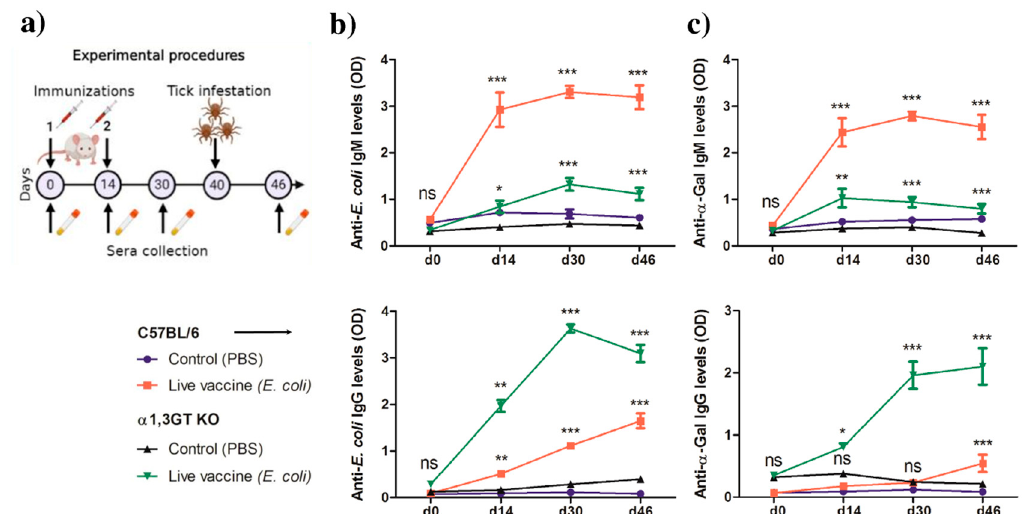
Figure 4. Antibody response of C57BL/6 and α 1,3GT KO mice after immunization with a live E. coli vaccine. ( a ) Mice were immunized twice and then infested with I. ricinus nymphs. The levels of IgM and IgG to E. coli proteins ( b ) and α -Gal ( c ) were quantified in sera by ELISA. Results shown are means and standard error values. Results were compared by two-way ANOVA with Bonferroni test applied for comparisons between control and immunized mice within each strain C57BL/6 or α 1,3GT KO (* p < 0.05, ** p < 0.001, *** p < 0.0001, ns—not significant; 1 experiment for each mice strain, n = 10